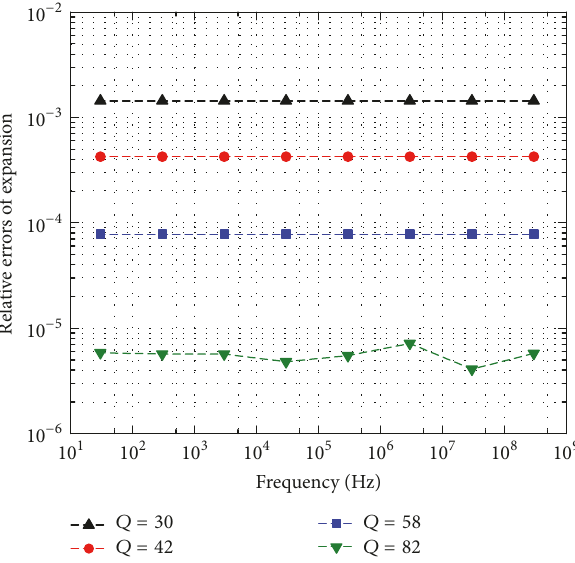
Figure 5: Relative errors of expansion.